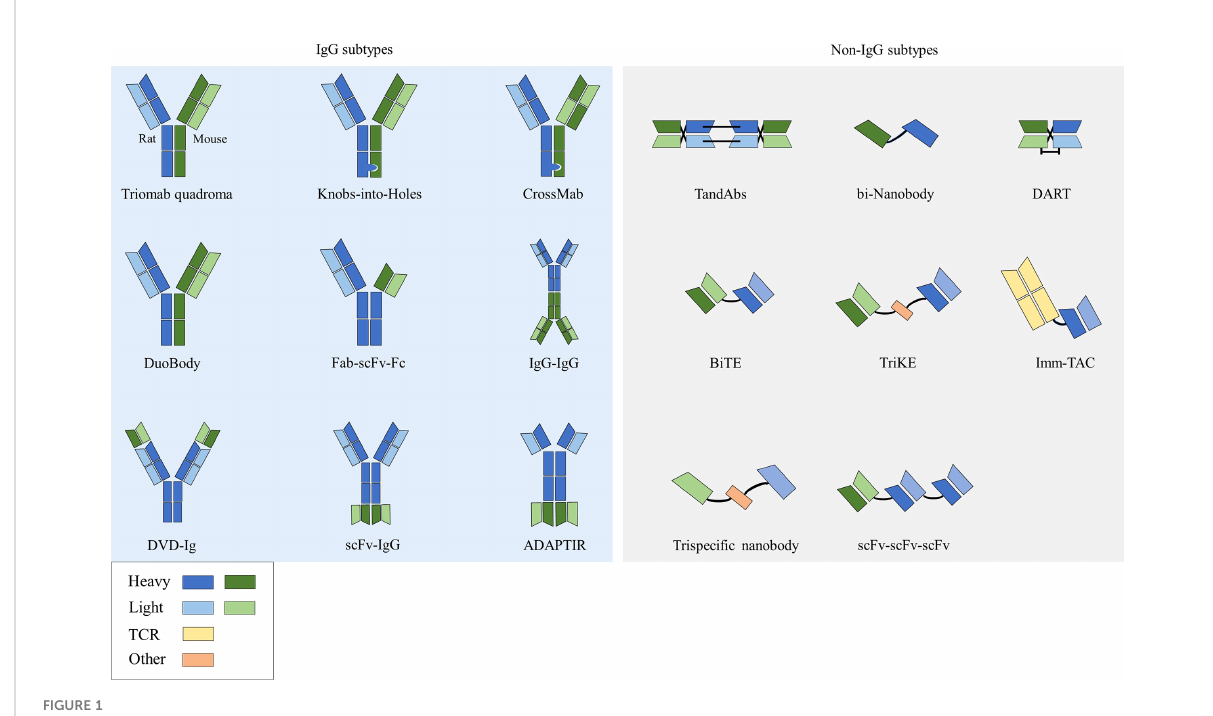
FIGURE 1 Structures of